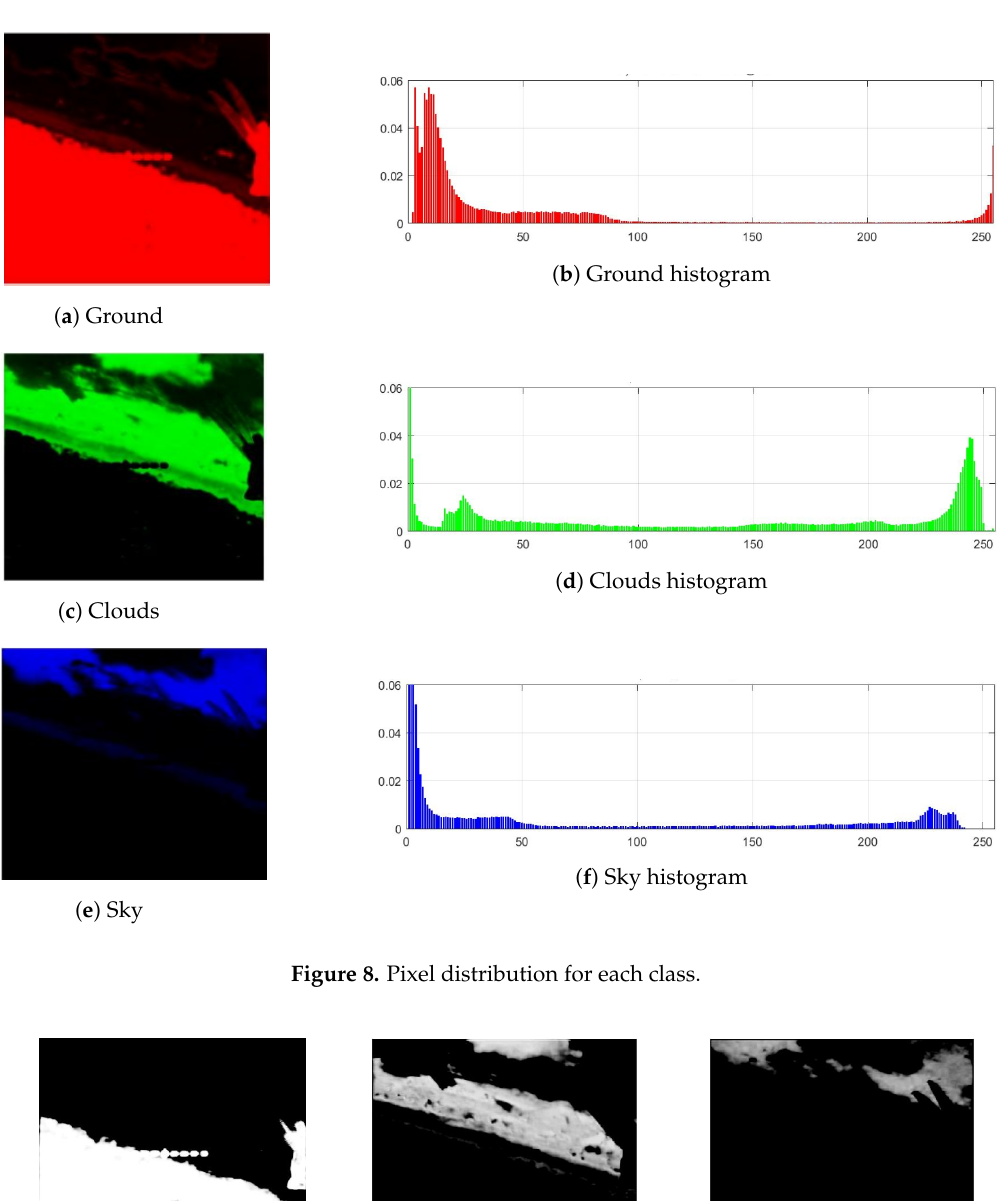
Figure 9. Scaled probabilities for each